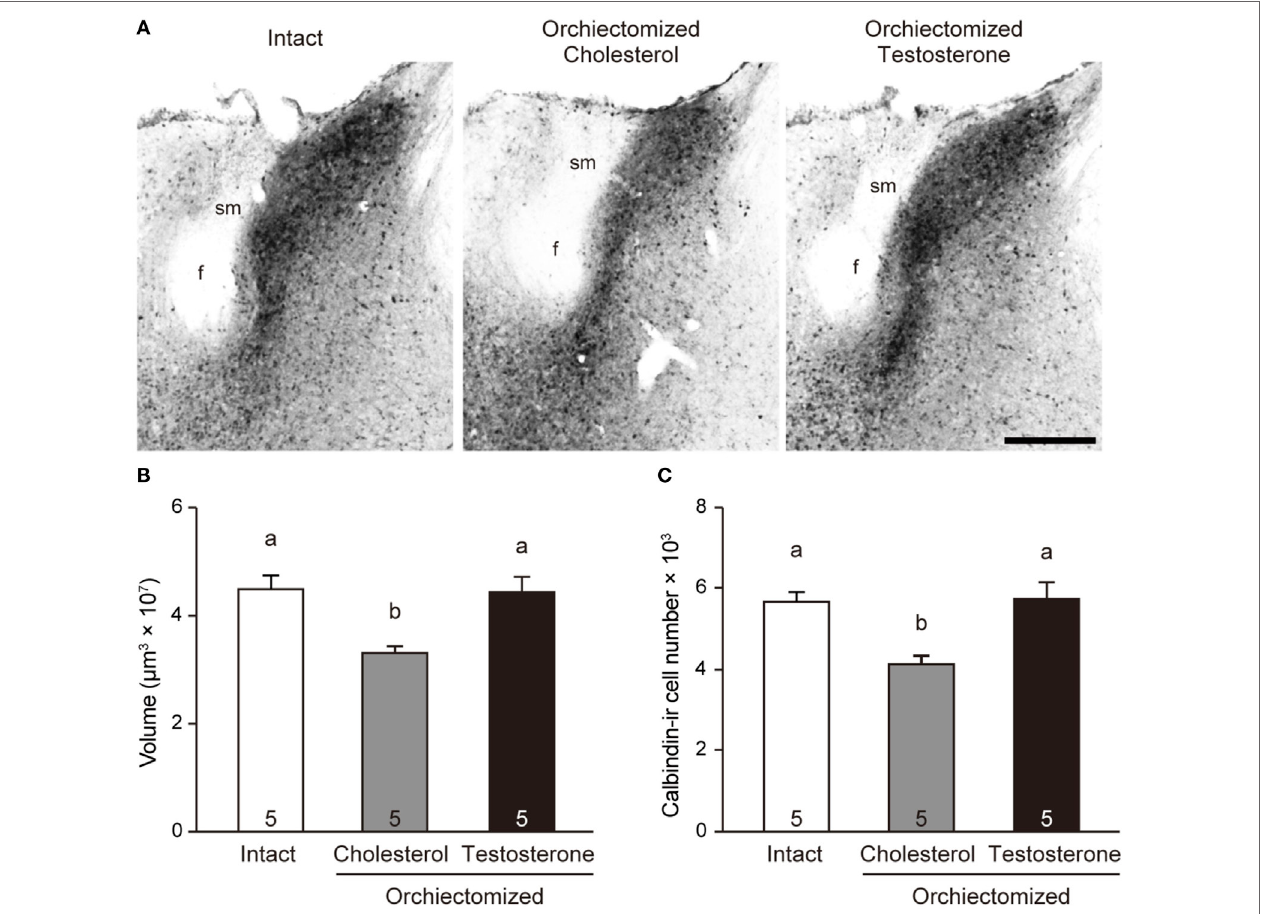
FigUre 5 | Effects of peripubertal testicular testosterone on the BNSTp in male mice. (a) Representative photomicrographs of brain sections from a gonadally intact adult male mouse, an adult male mouse subjected to orchiectomy and cholesterol implantation at PD20, and an adult male mouse subjected to orchiectomy and testosterone implantation at PD20. Scale bar indicates 300 µm. f, fornix; sm, stria medullaris of the thalamus. (B) The volume of the BNSTp in adult male mice. (c) The number of the calbindin-ir cells in the BNSTp of adult male mice. The numbers in the columns indicate the numbers of animals. Differences in values that are significantly ( p < 0.05) different from each other are indicated with